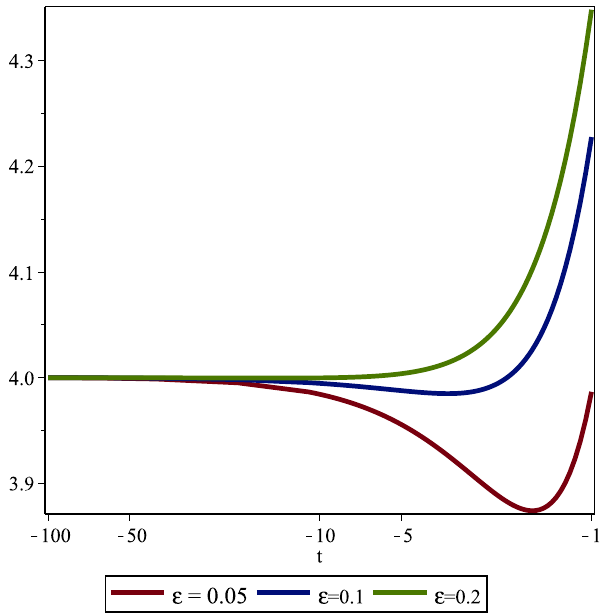
Figure 4. Graphs of approximate solutions u ( z ) of the form (50) at the point x = 1 for different values of ε .